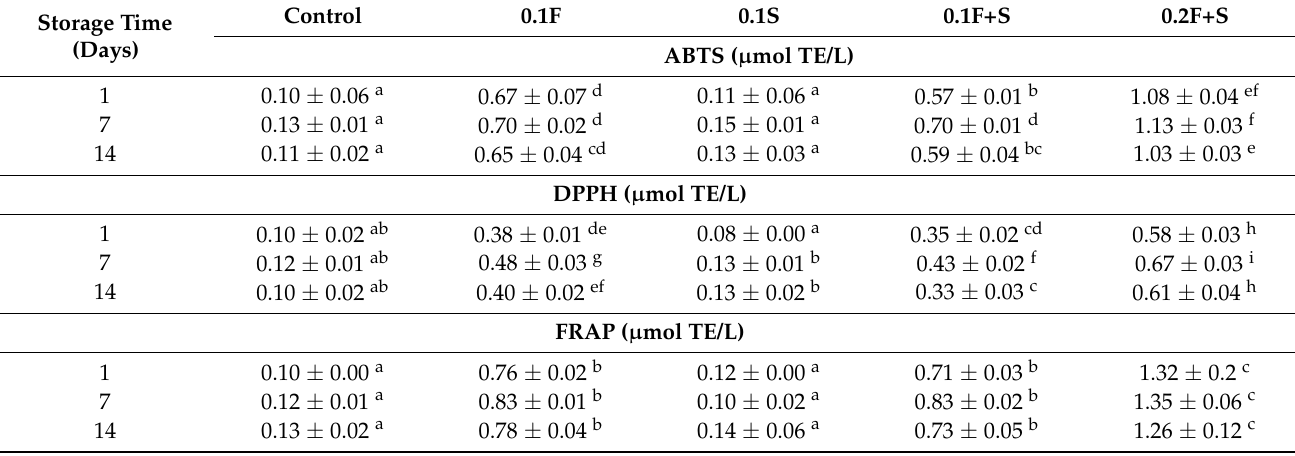
Table 7. Antioxidant activity, measured by ABTS, DPPH and FRAP methods, in yoghurts during storage. Storage